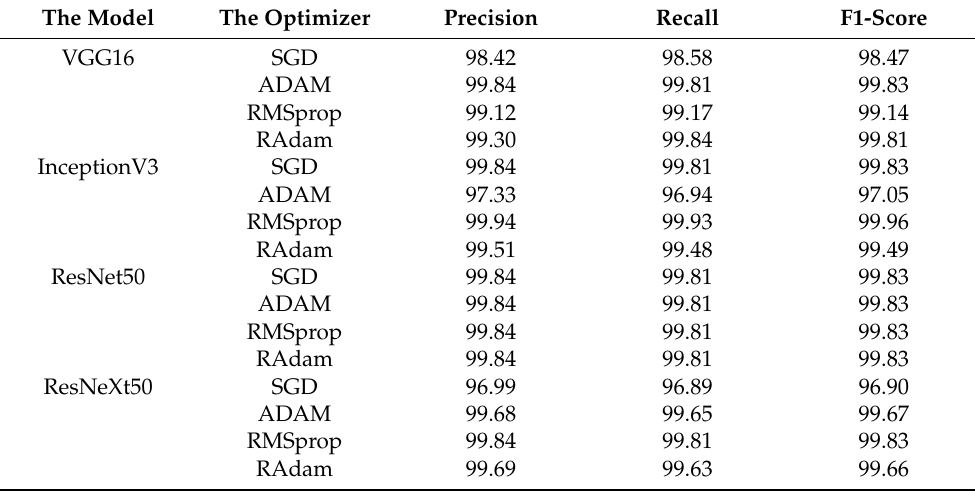
Table 4. Results of VGG16, InceptionV3, ResNet50, and ResNeXt50 with four optimizers.